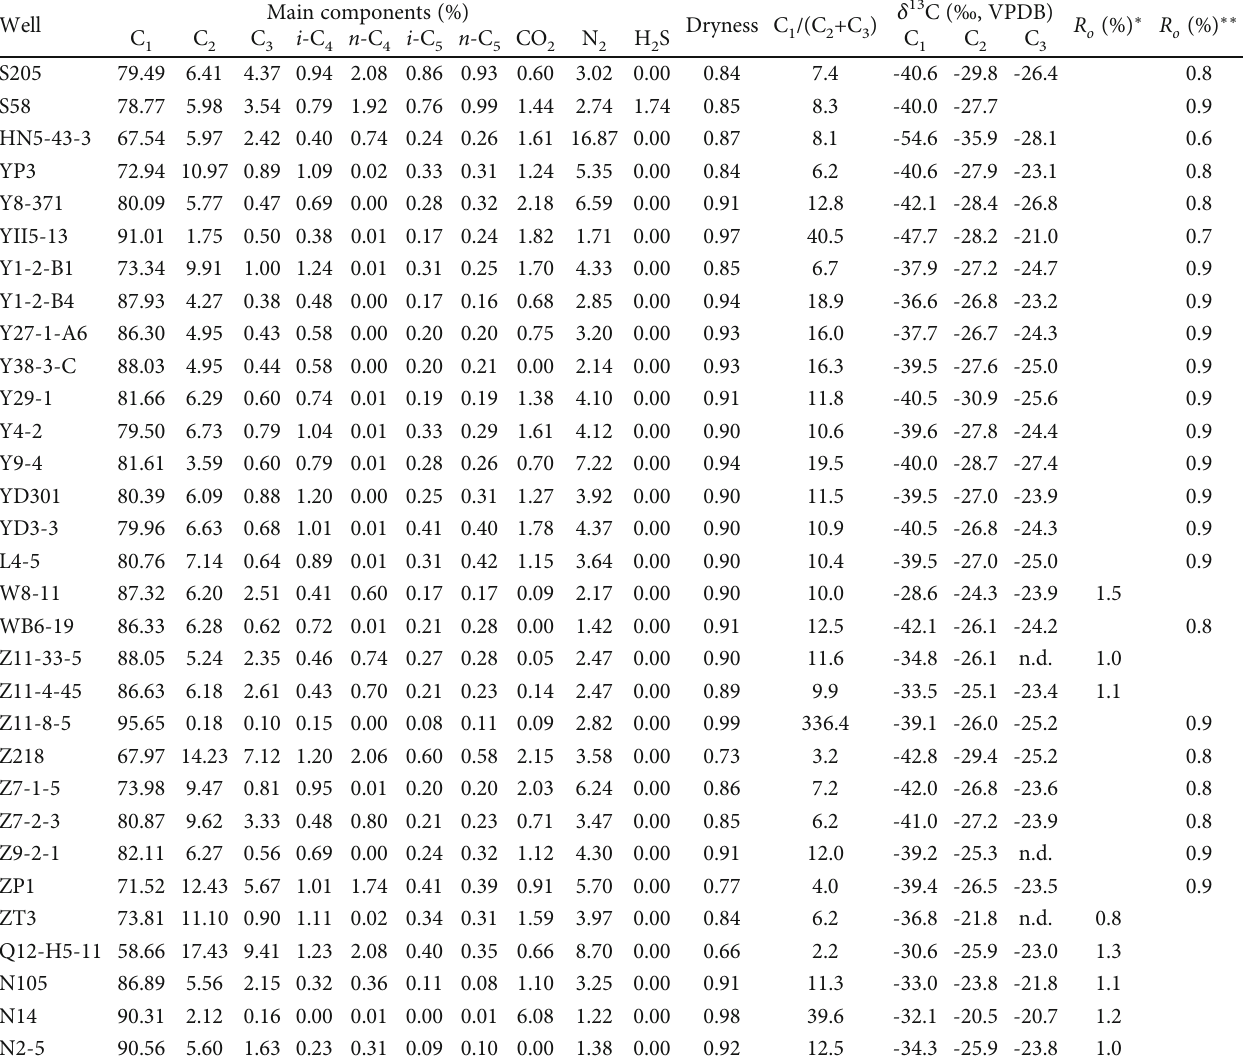
Table 3: Component and isotope properties of natural gas in the western Qaidam Basin.